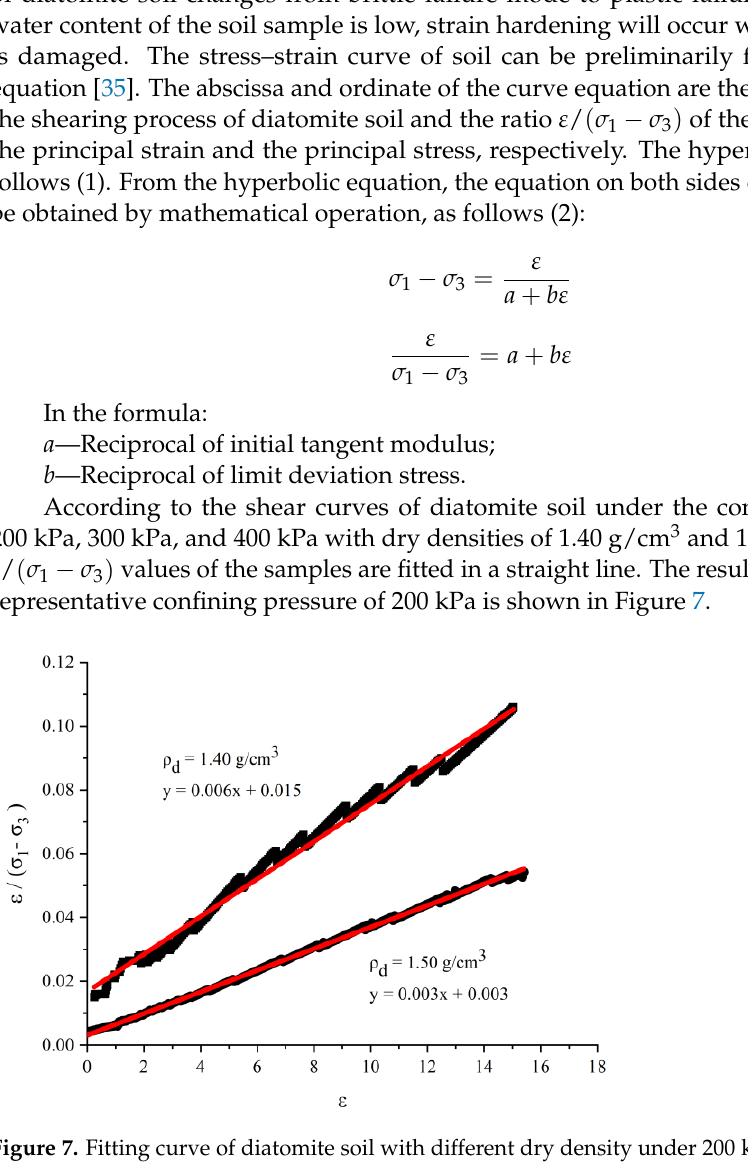
Table 3. Fitting line parameters.